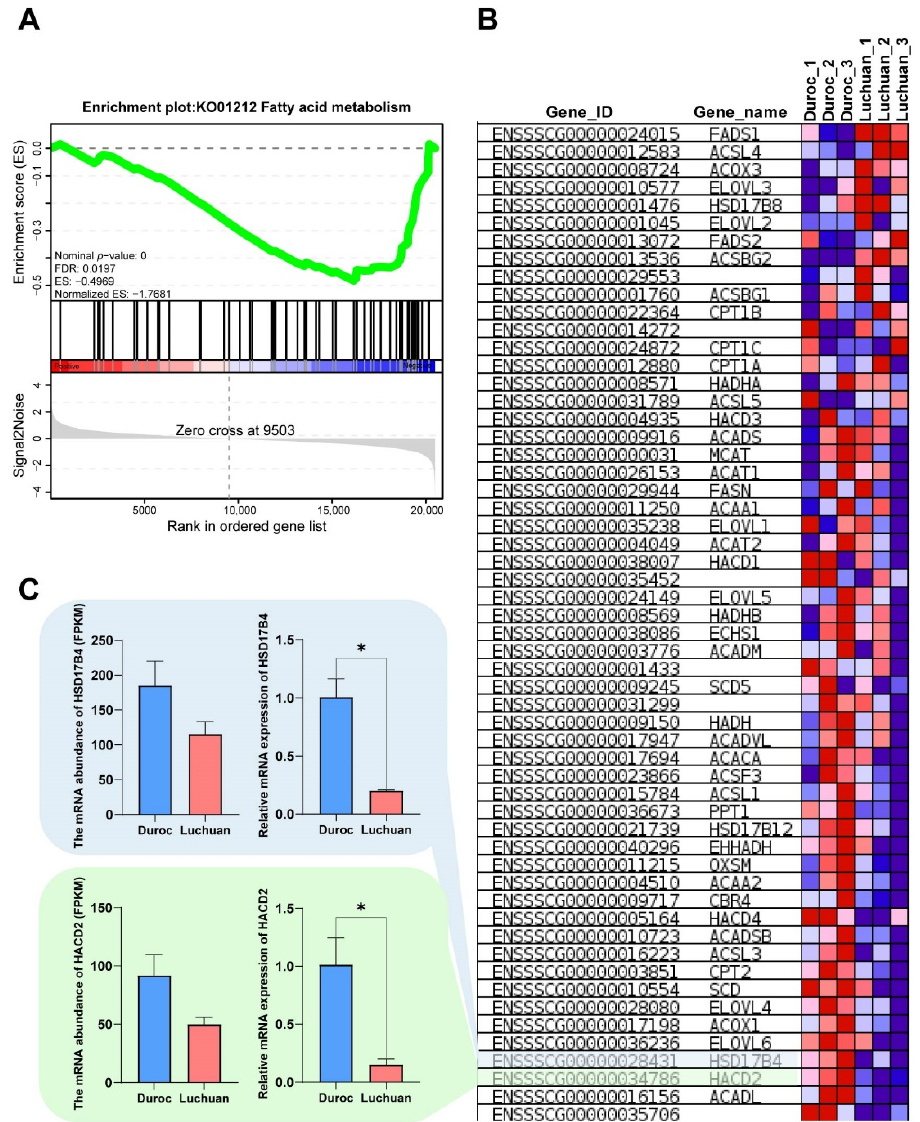
Figure 4. Functional gene screening and functional verification. ( A ) GSEA-KEGG analysis of the transcriptome. A pathway of positive enrichment score is up-regulated, whereas a pathway of negative enrichment score is down-regulated. ( B ) Gene expression heatmap of the fatty acid metabolic pathway. The color key (from blue to red) of abundance value indicated low to high expression levels. ( C ) Gene expression levels quantified by RNA-seq and RT-qPCR. HACD2, 3-hydroxyacyl-CoA dehydratase 2. HSD17B4, hydroxysteroid 17-beta dehydrogenase 4. The data are expressed as mean ± SD. * p <